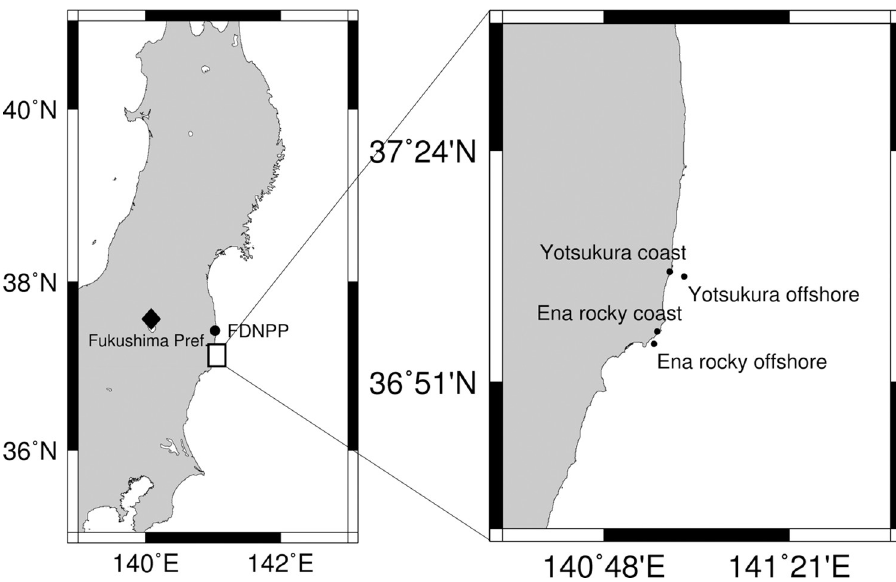
Fig 1. Sea urchin sampling sites on the Fukushima coast. The Yotsukura and Ena stations are about 35 and 50 km south of the Fukushima Daiichi Nuclear Power Plant (FDNPP),